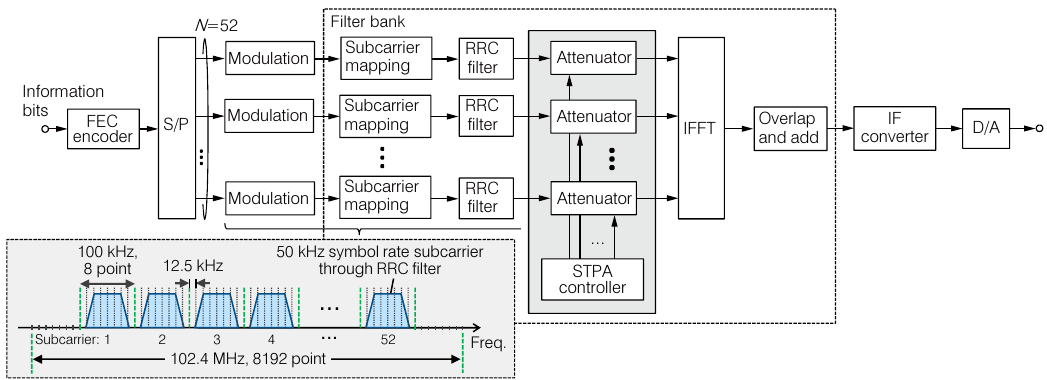
Figure 4. Transmitter employing STPA. S/P: serial-to-parallel; RRC: root raised cosine; IFFT: inverse fast Fourier transform; IF: intermediate frequency; D/A: digital-to-analog.